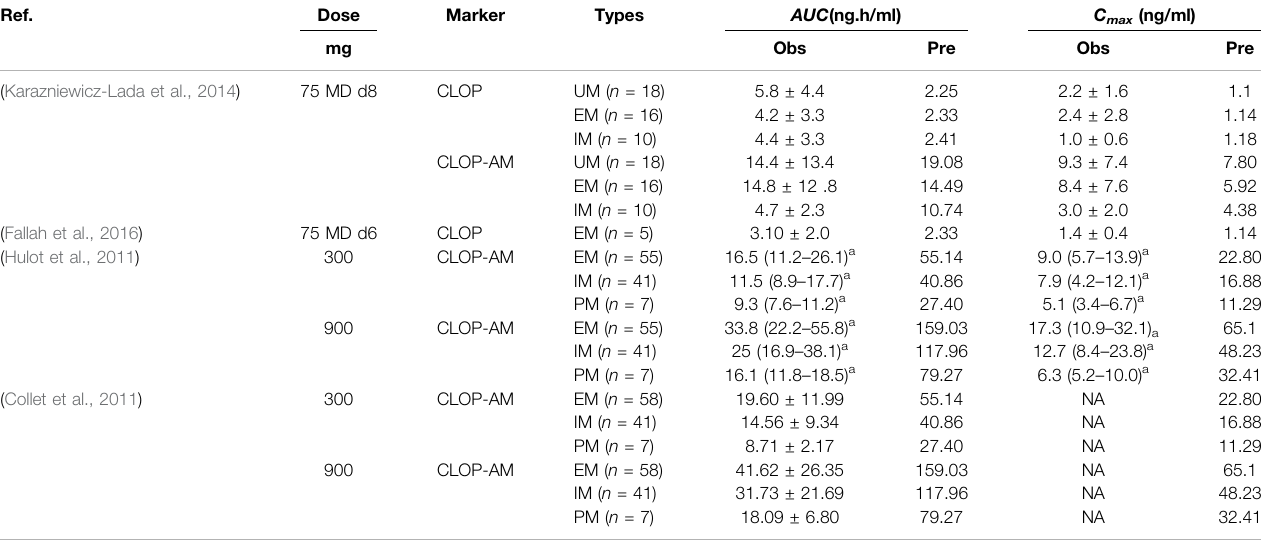
TABLE 5 | The observed and predicted plasma pharmacokinetics parameters in CAD patients.